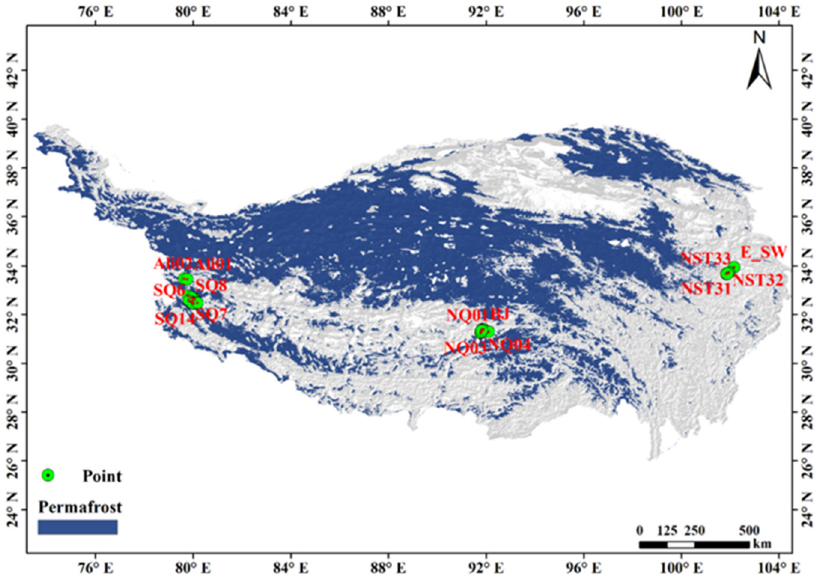
Figure 5. Location of field verification points.